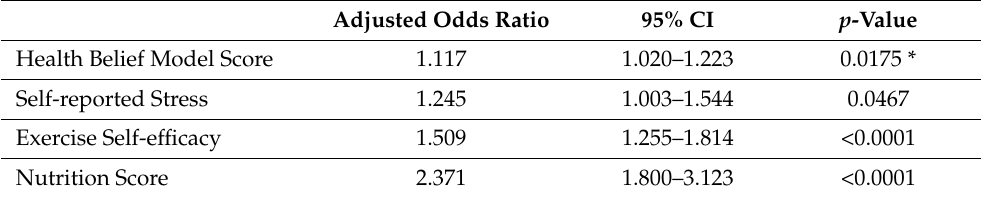
Table 2. Health Belief Model and Exercise Behavior Change: Ordinal Logistic Regression Model. Adjusted Odds Ratio 95% CI p -Value Health Belief Model Score 1.117 1.020–1.223 0.0175 * Self-reported Stress 1.245 1.003–1.544 0.0467 Exercise Self-efficacy 1.509 Nutrition Score